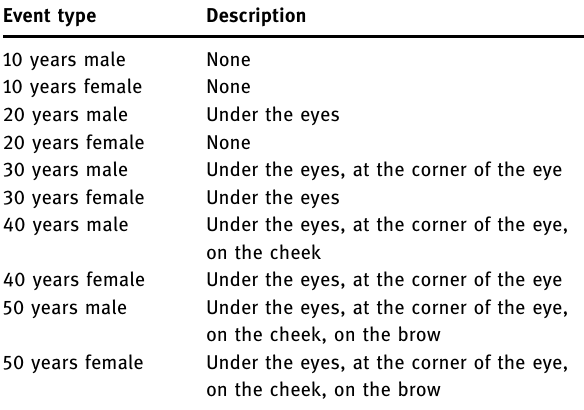
Table 1: Wrinkle progression with age Event